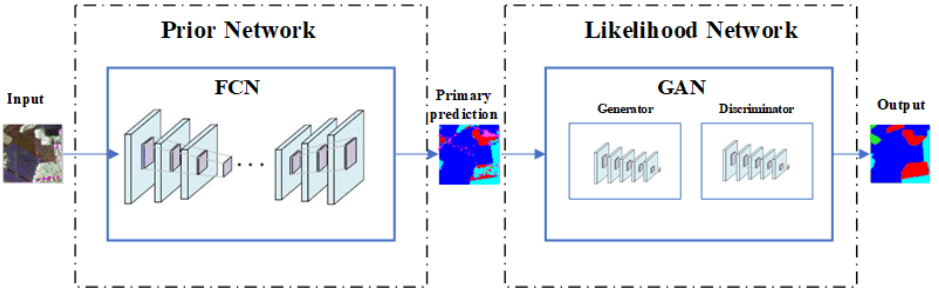
Figure 1. Bayesian segmentation framework.